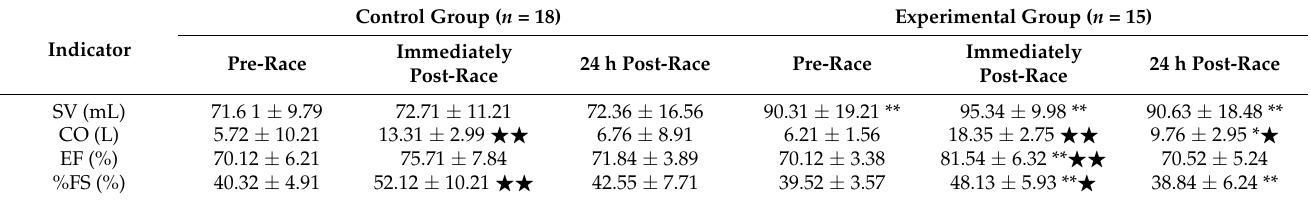
Table 3. Changes in cardiac functional indicators before, immediately after, and 24 h after the marathon